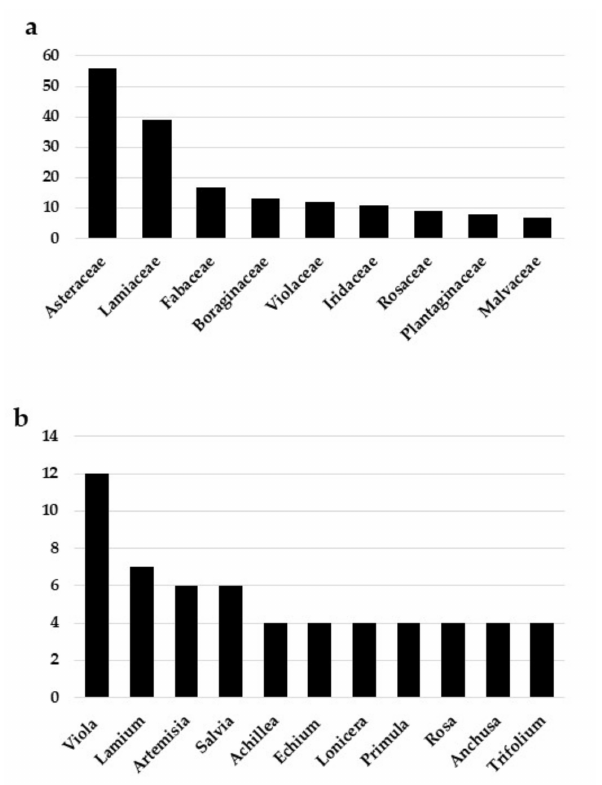
Figure 1. Most cited families and number of species per family ( a ); most cited genera and number of species per genus ( b ).